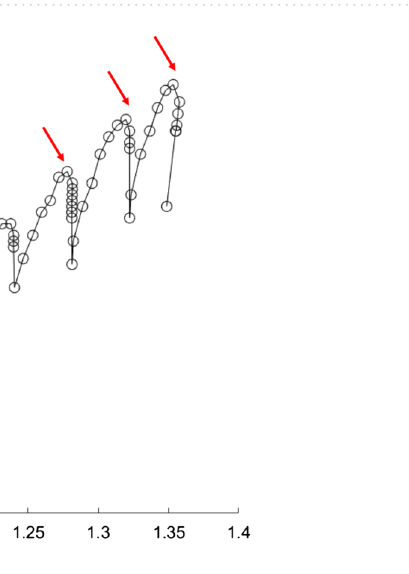
Figure 3. Nominal stress versus optically-measured stretch for sample 8. The relaxations are due to the pauses for MPI acquisition (red